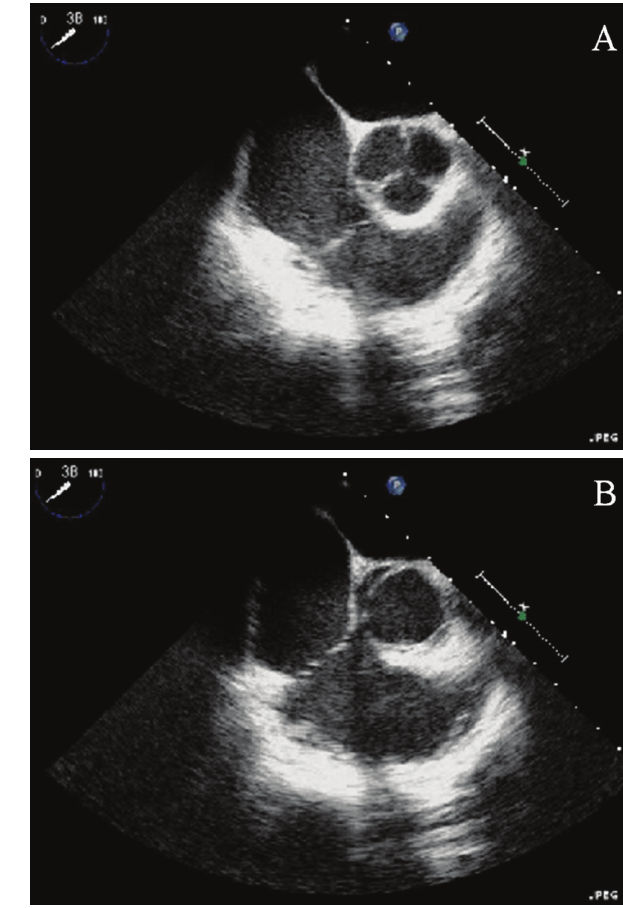
Figure 2 - A short axis view of the aorta, showing the aortic valve. (A) Three commissures with equal-sized leaflets during diastole. (B) A characteristic doming configuration of a bicuspid aortic valve during